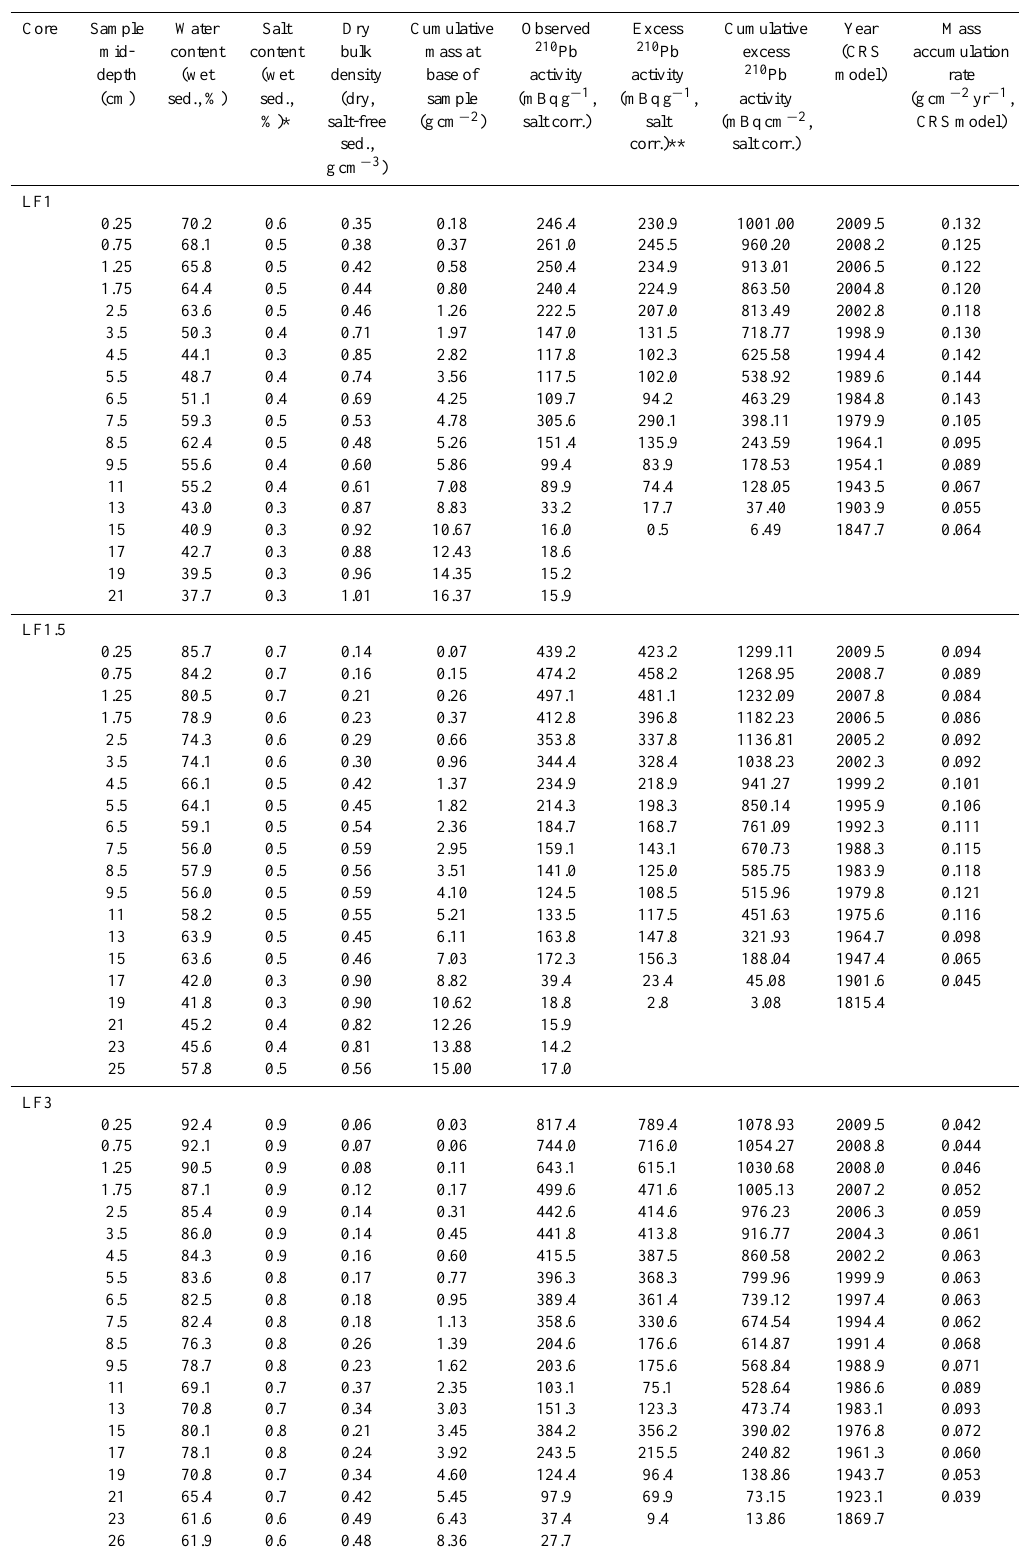
Table C1. Sediment solid phase parameters used in the calculation of 210 Pb-based age models. Core